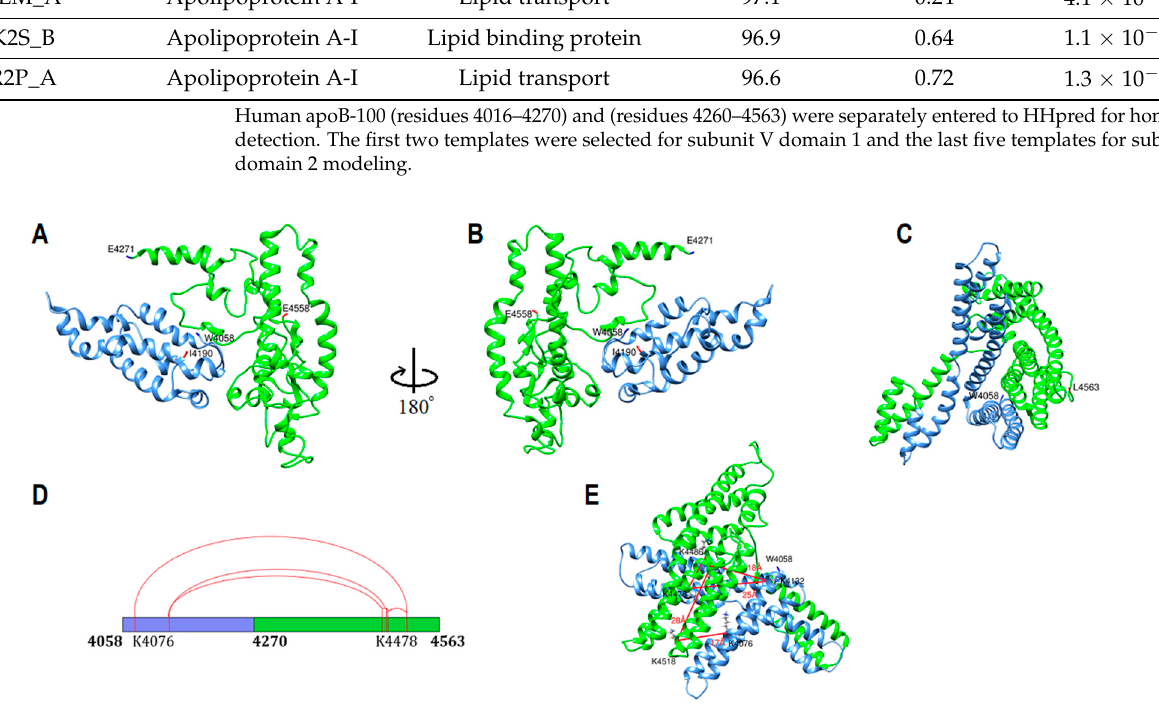
Figure 6. ApoB-100 subunit V structure and cross-link map. ( A , B ) Ribbon representation of ApoB-100 subunit V primary structure generated by homology modeling. Domain 1 (blue) starts at W4058 through I4190, and domain 2 (green) begins at E4271 through E4558. ( C ) Entire subunit V generated by I-TASSER using the primary structure as a template. Subunit V structure is composed of helix-turn- helix and short coils. ( D ) DSSO cross-link map on subunit V linear sequence with two domains is colored according to the structure. ( E ) DSSO cross-link map on subunit V ribbon representation with five intra-subunit cross-links (red lines) between lysine residues. One cross-link between K4485-K4518 has slightly exceeded the 26 Å limit (28